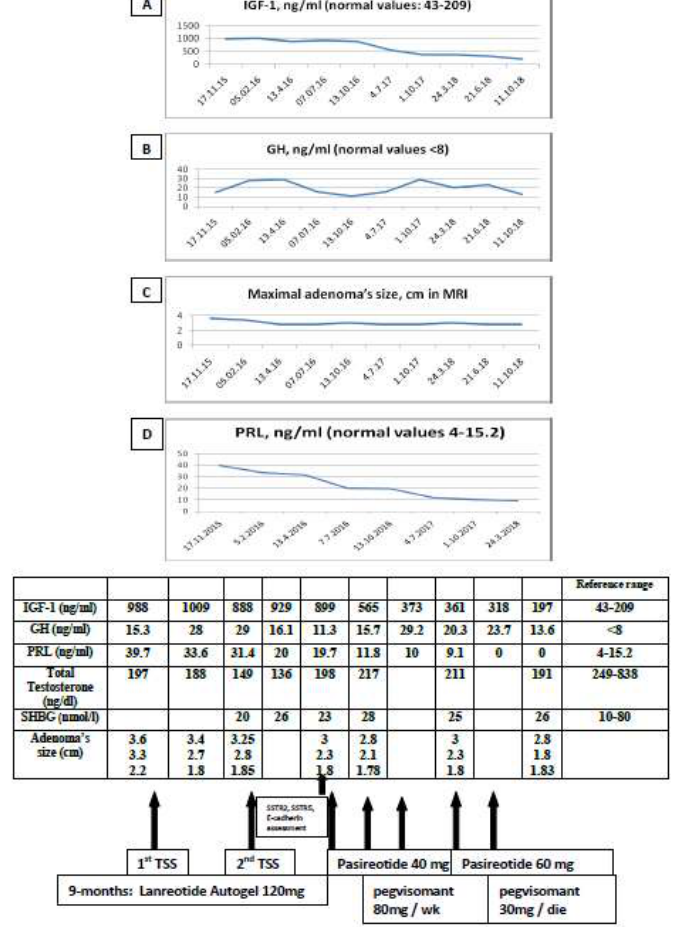
Figure 2. Pharmacological effects on serum IGF-1 ( A ), growth hormone (GH) ( B ), prolactin levels ( C ), and adenoma size ( D ) with different therapeutic modalities.